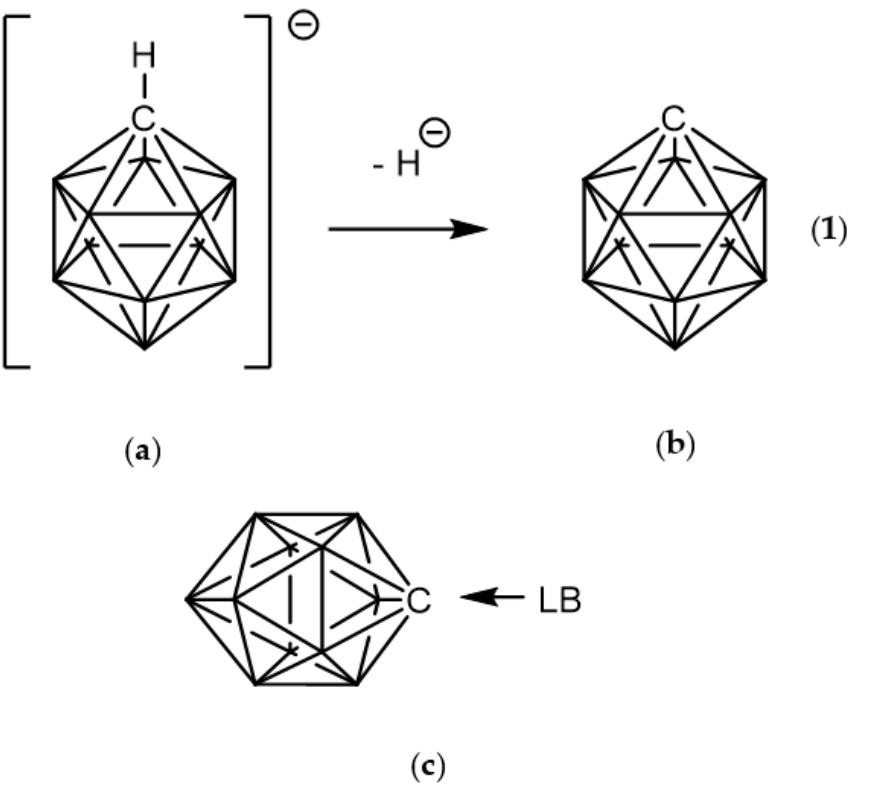
Figure 1. Removal of hydride from the C-H bond in ( a ) closo -monocarbadodecaborate anion CB 11 H 12( − ) leads to ( b ) carbocation ylide or carbenoid CB 11 H 11 ( 1 ). ( c ) Complex formation between ( 1 ) and a Lewis base (LB). All vertices correspond to B-H moieties except for the carbon vertex.